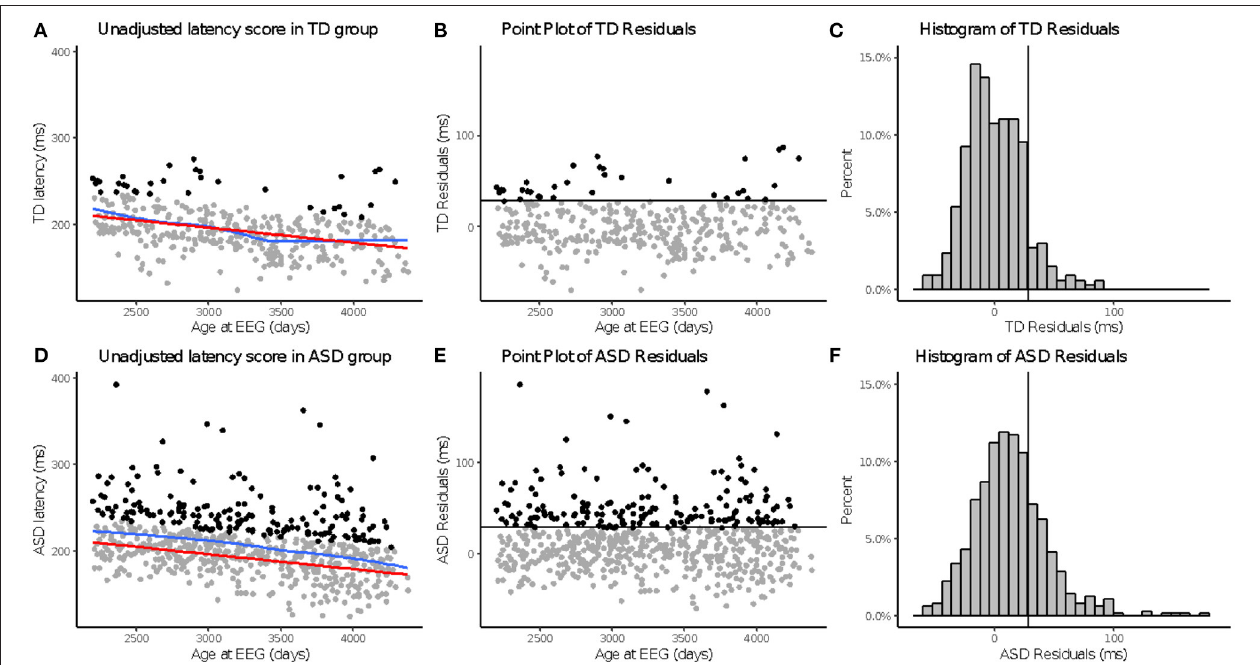
FIGURE 2 | a N170 latency to upright faces. Age-adjusted N170L in response to upright faces. Graphs depict the TD group in the top row (A–C) and ASD in the bottom row (D–F) . (A,D) Red line indicates predicted values of N170L based on the fitted model, while the blue line indicates the locally estimated scatterplot smoothing (LOESS) for each group. (B,E) Residual values calculated using the fitted model. (C,F) Black line indicates a cutoff point derived from the upper 10% of all age-adjusted N170L scores in the TD group. Data points greater than that cutoff point are black (A,B,D,E)